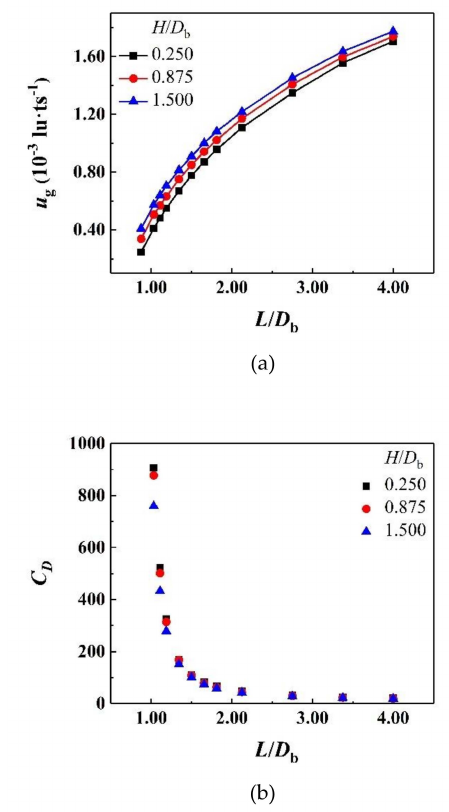
Figure 8. Variations of u g ( a ) and C D ( b ) with channel width at Re Gr = 100 and Eo =